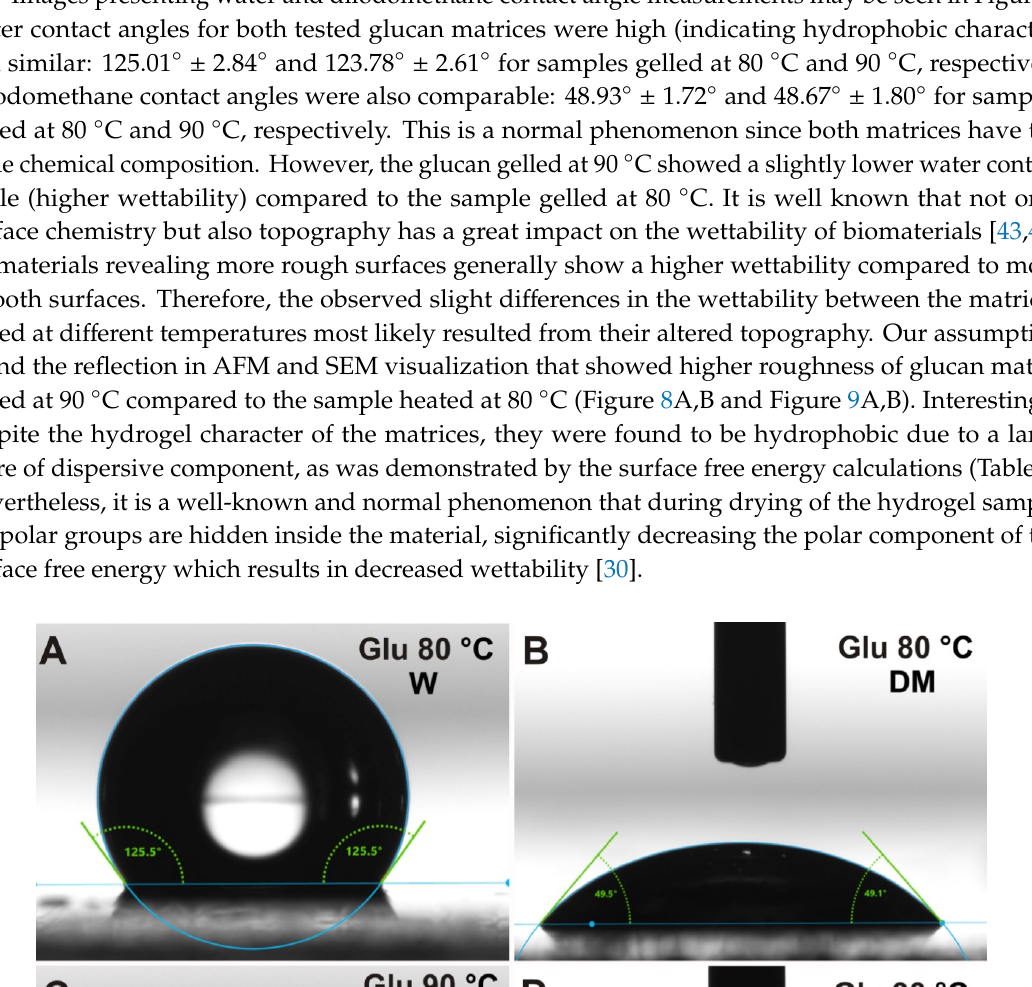
Table 4. Surface free energy and its dispersive and polar components calculated for glucan matrices gelled at different temperatures.